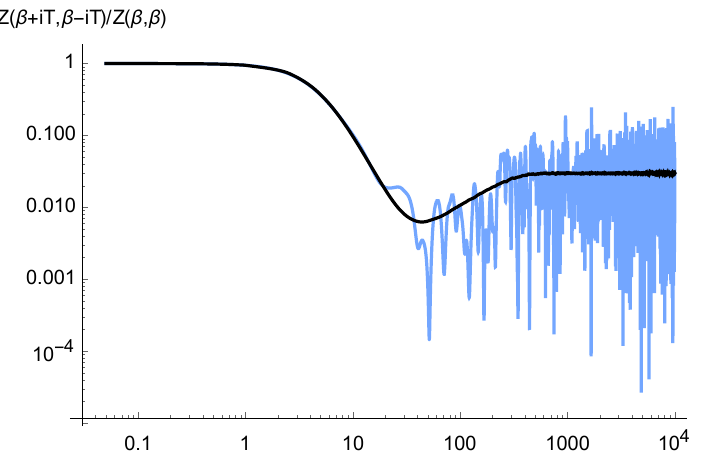
Figure 1 . A log-log plot of the spectral form factor Z ( β + iT, β − iT ) (normalized by Z ( β, β ) ) as a function of T for the Gaussian Unitary Ensemble (GUE). We have considered the GUE for 500 × 500 matrices with the real and imaginary parts of each matrix element sampled from a Gaussian distribution with variance 1 / 500 . The black curve is averaged over 10000 samples and the light blue curve is a single